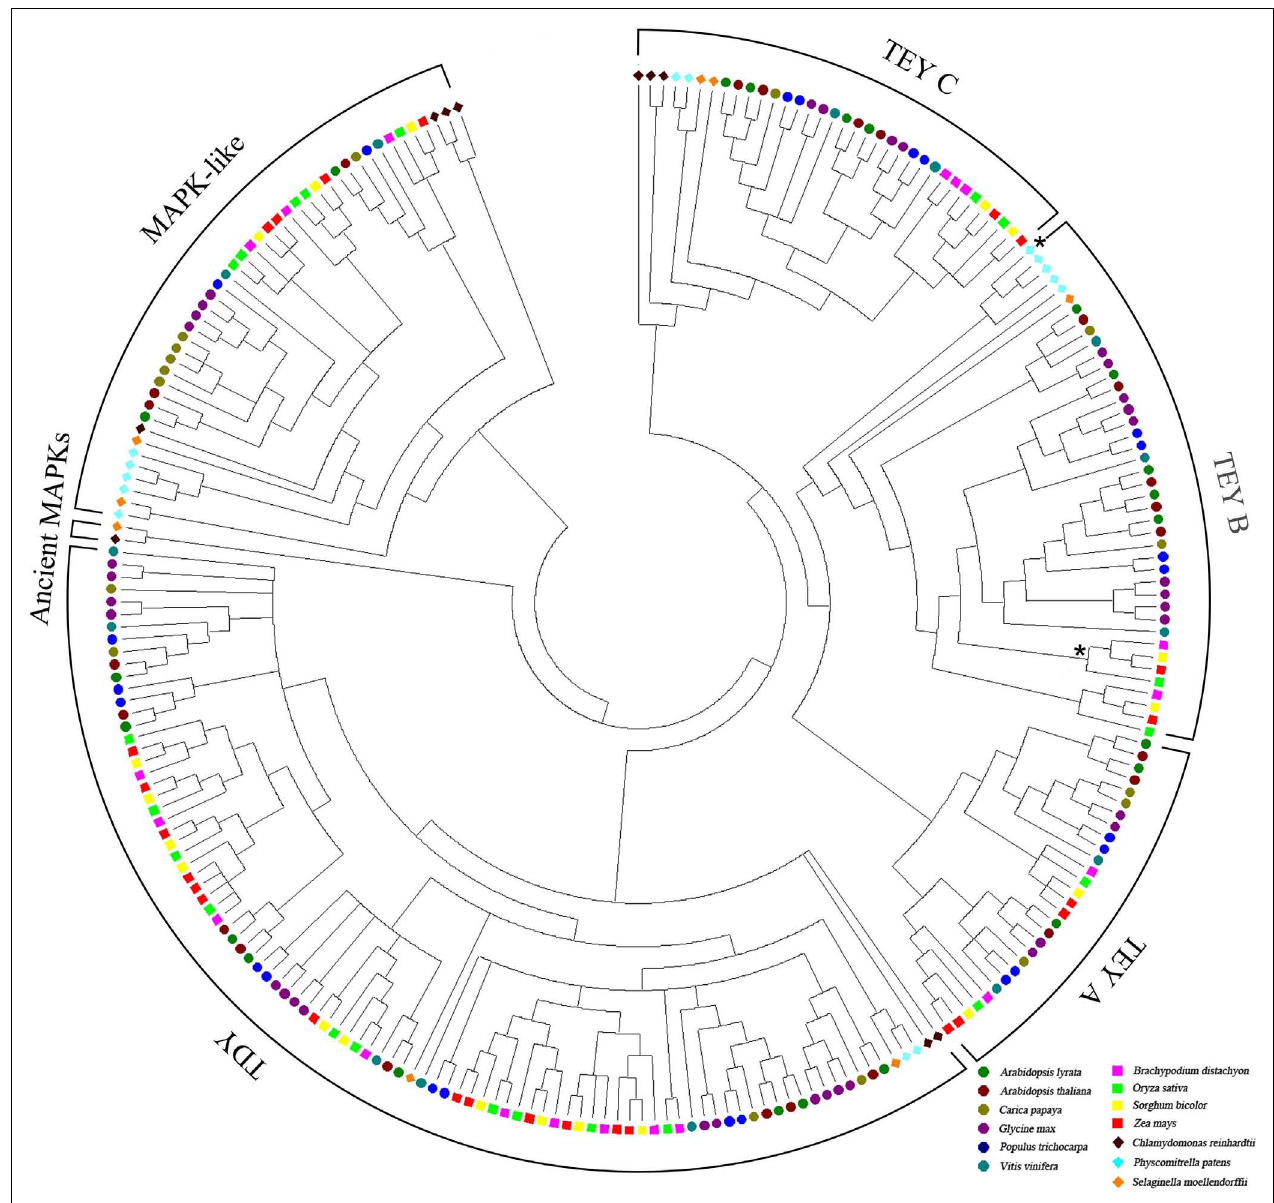
lengths can be found in the linear version of this tree in Figure S1 in Supplementary Material.The monocot clade and the PP sequence with the atypical MEY activation loop within theTEY-B clade are marked by